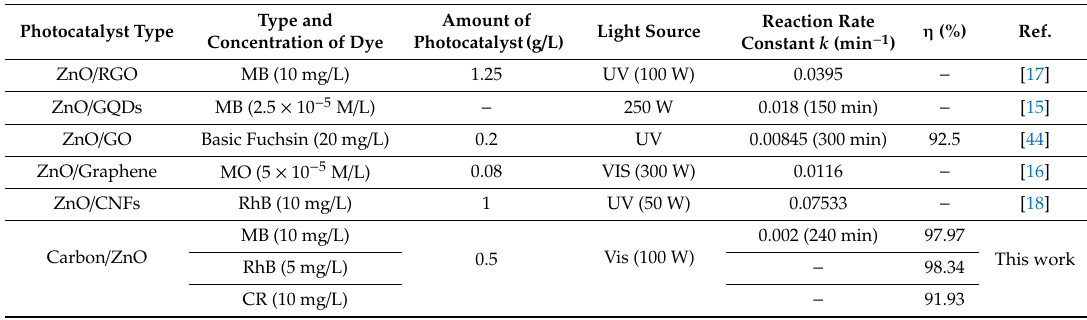
Table 2. Photocatalytic activities of carbon / ZnO nanostructured materials.